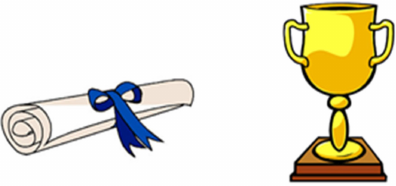
Figure 5. Example of the Picture-Based Comprehension Measure in the Self-Paced Reading